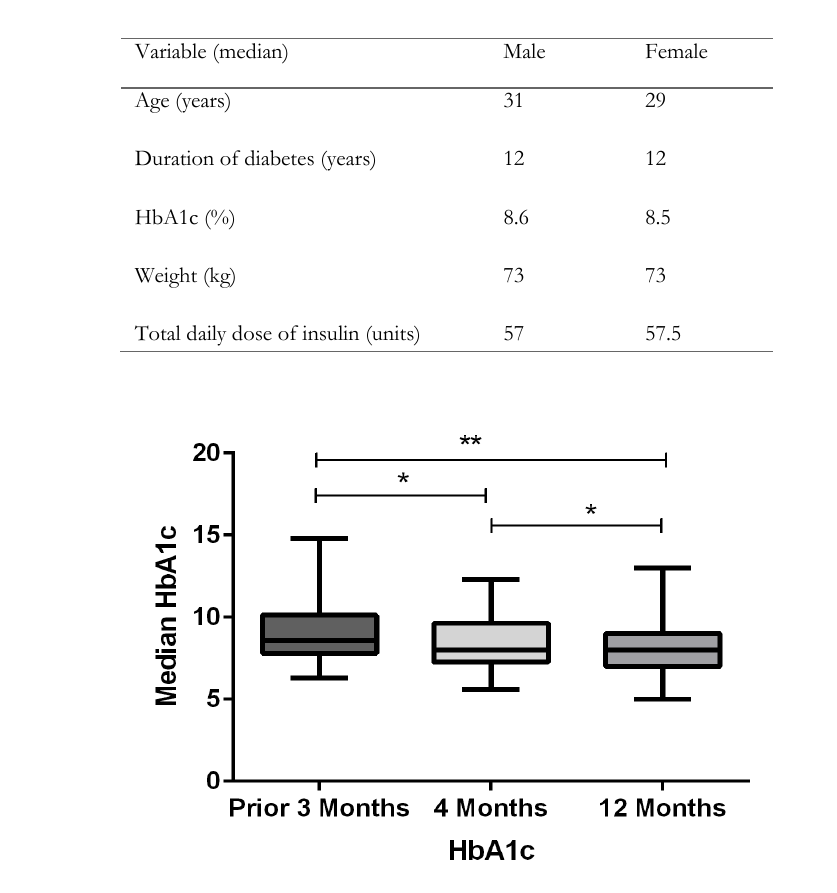
Table 1: Baseline characteristics of the study population (n=52)